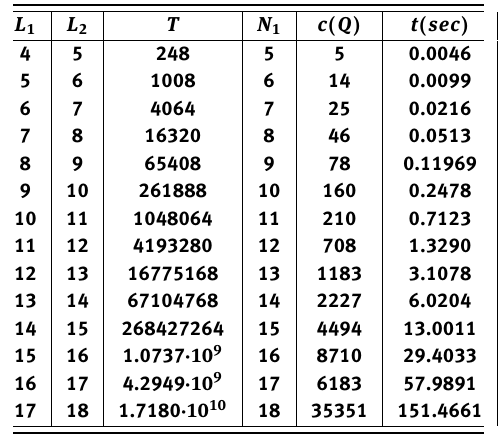
Table 2. Numerical results for the algorithm when N 1 = L